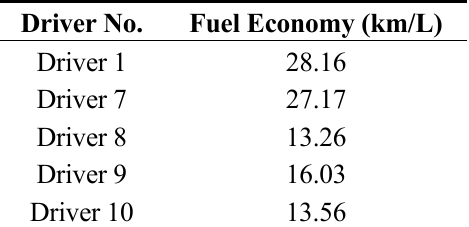
Table 3. Fuel economy comparison between cautious driver and aggressive driver for the FTP-72 driving